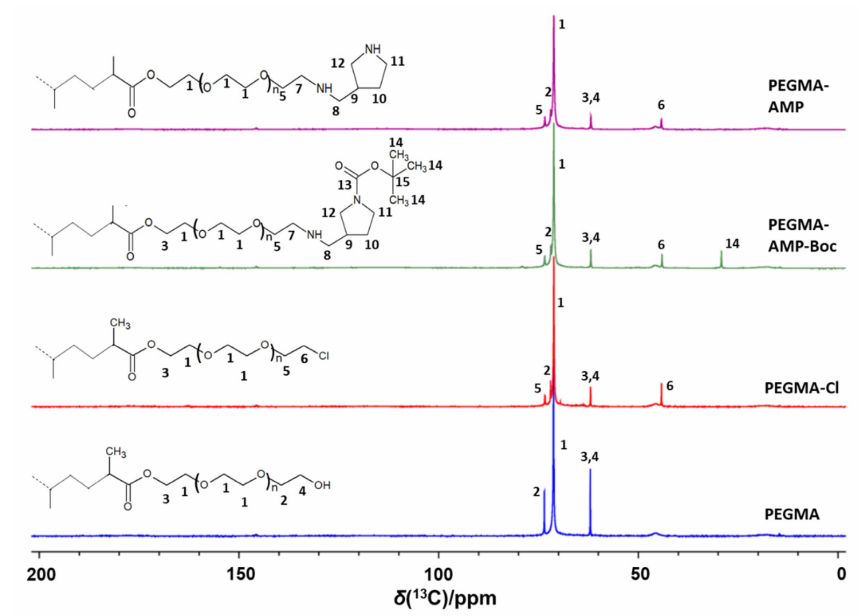
Figure 3. 1 H decoupled 13 C direct-excitation solid-state NMR spectra of (from bottom to top) the PEGMA support, the chlorine-functionalized PEGMA-Cl, the protected amine-functionalized PEGMA-AMP-Boc-3 and the aminated